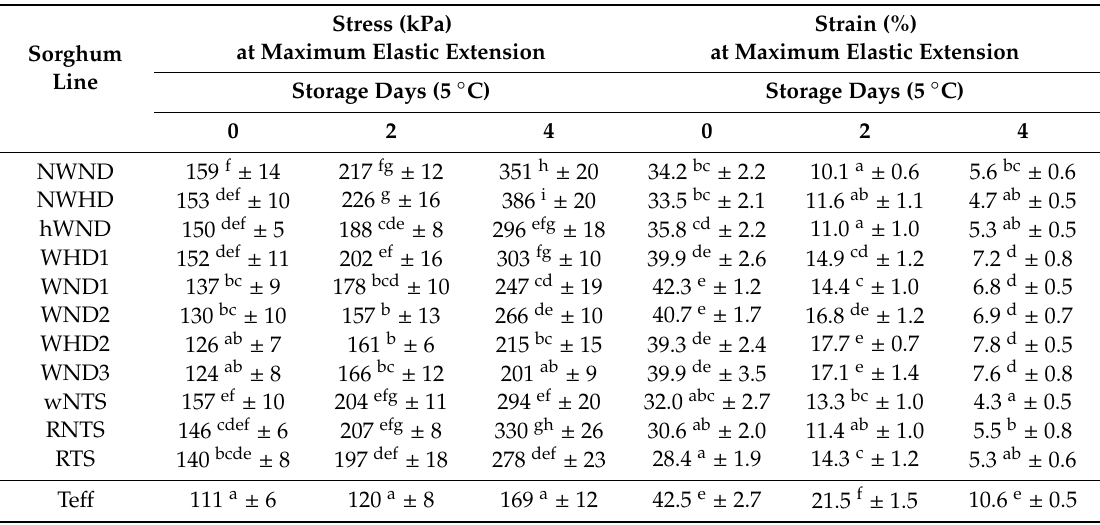
Table 4. E ff ects of the waxy and high protein digestibility HD traits on instrumental textural properties of fresh and stored sorghum injera as compared with te ff